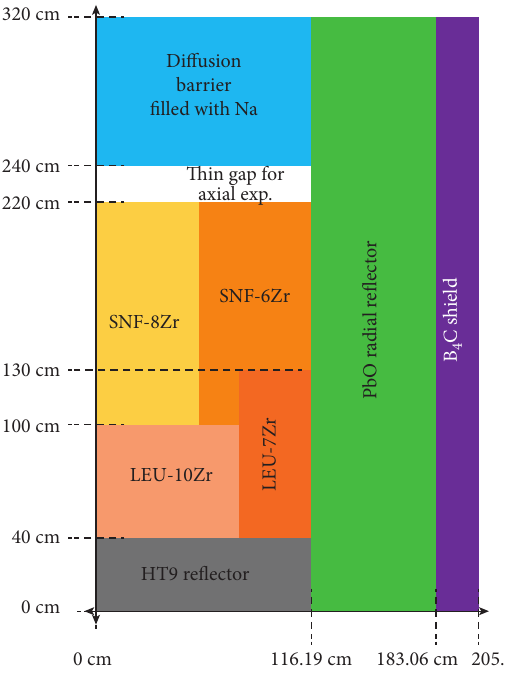
Figure 2: Axial sectional view of